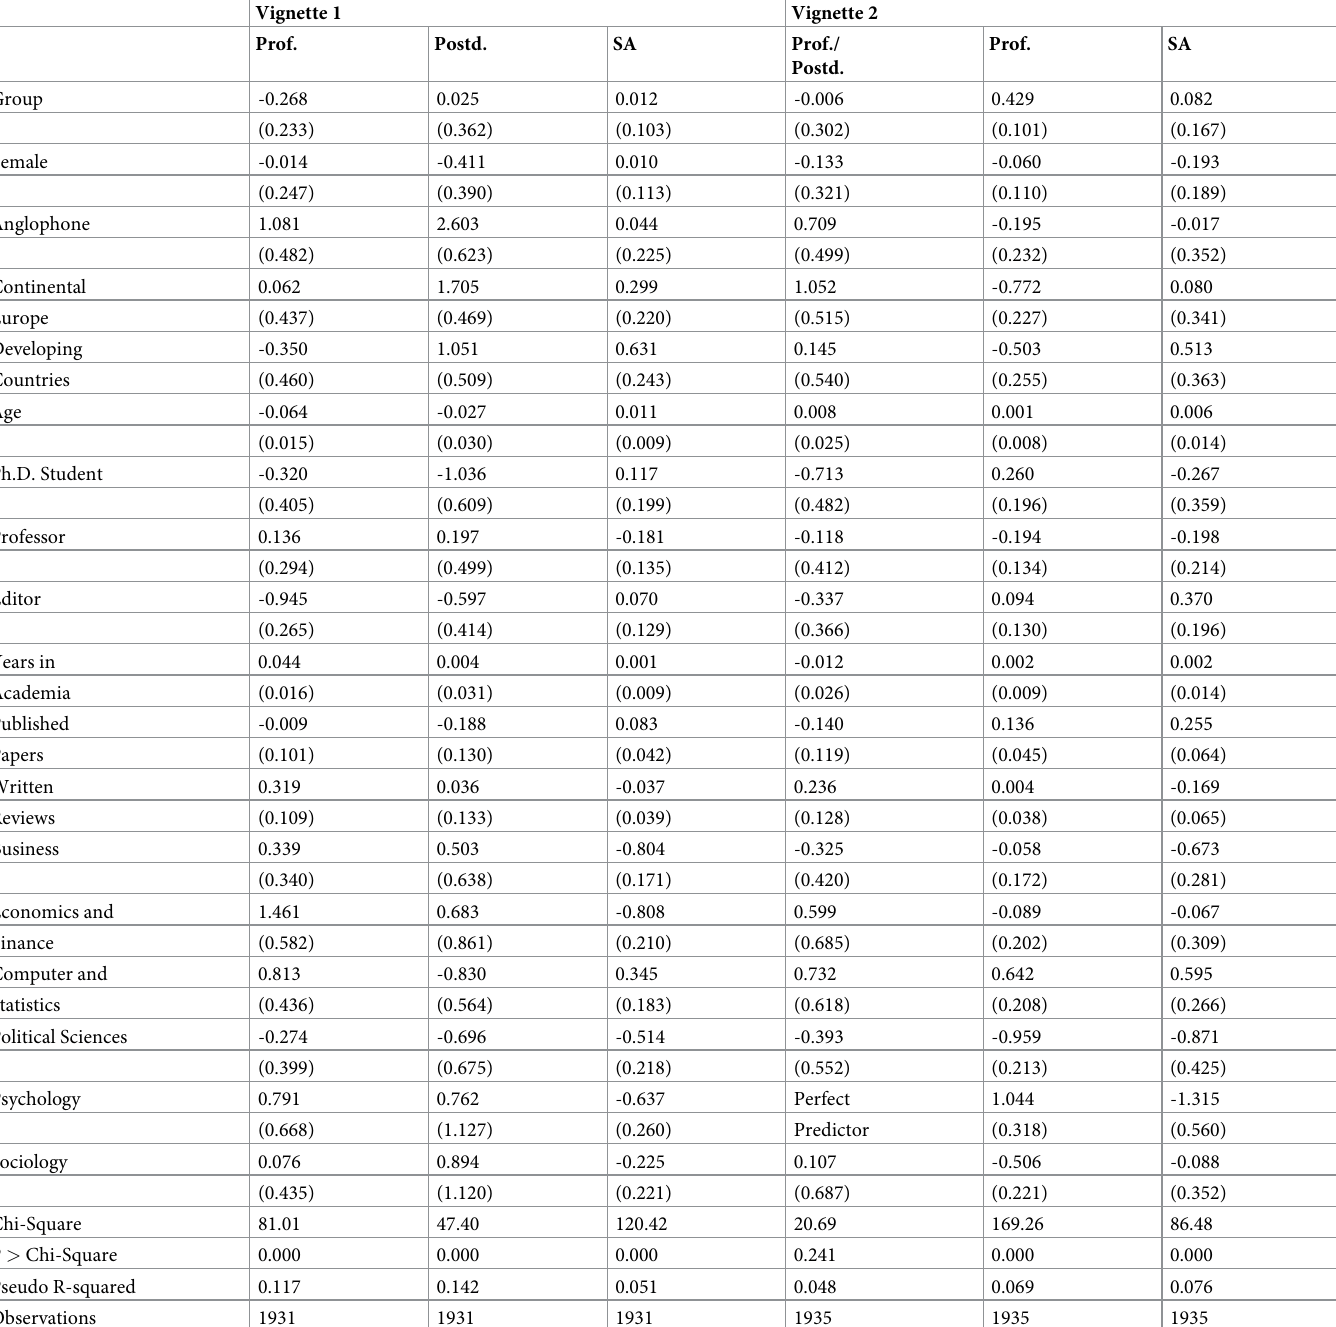
Table 3. Regression results of hypothetical authorship assignments in the